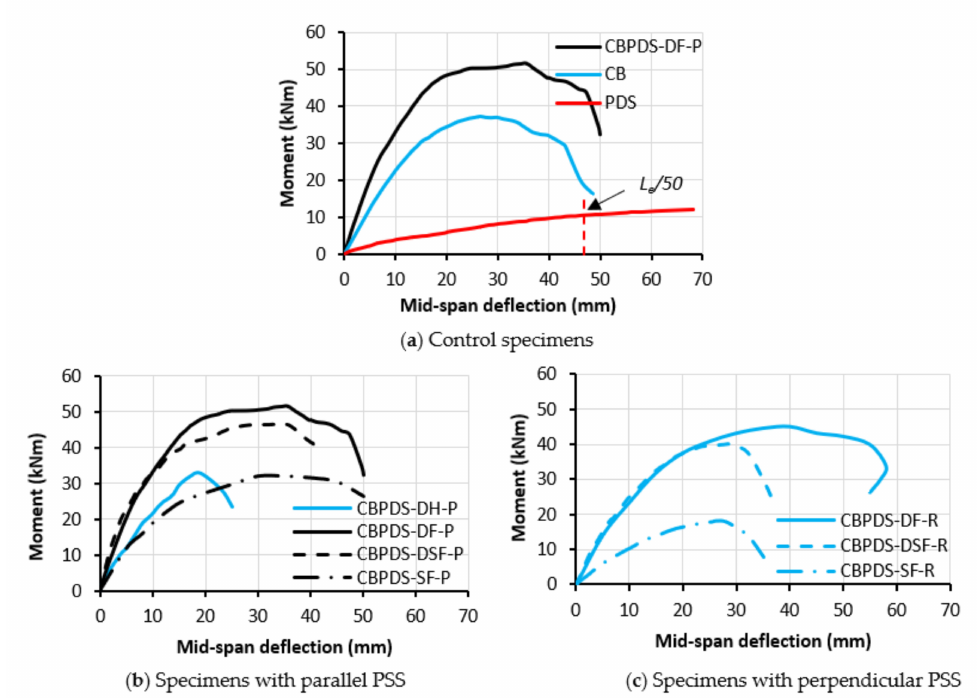
Figure 15. Moment–deflection relationships of CBPDS